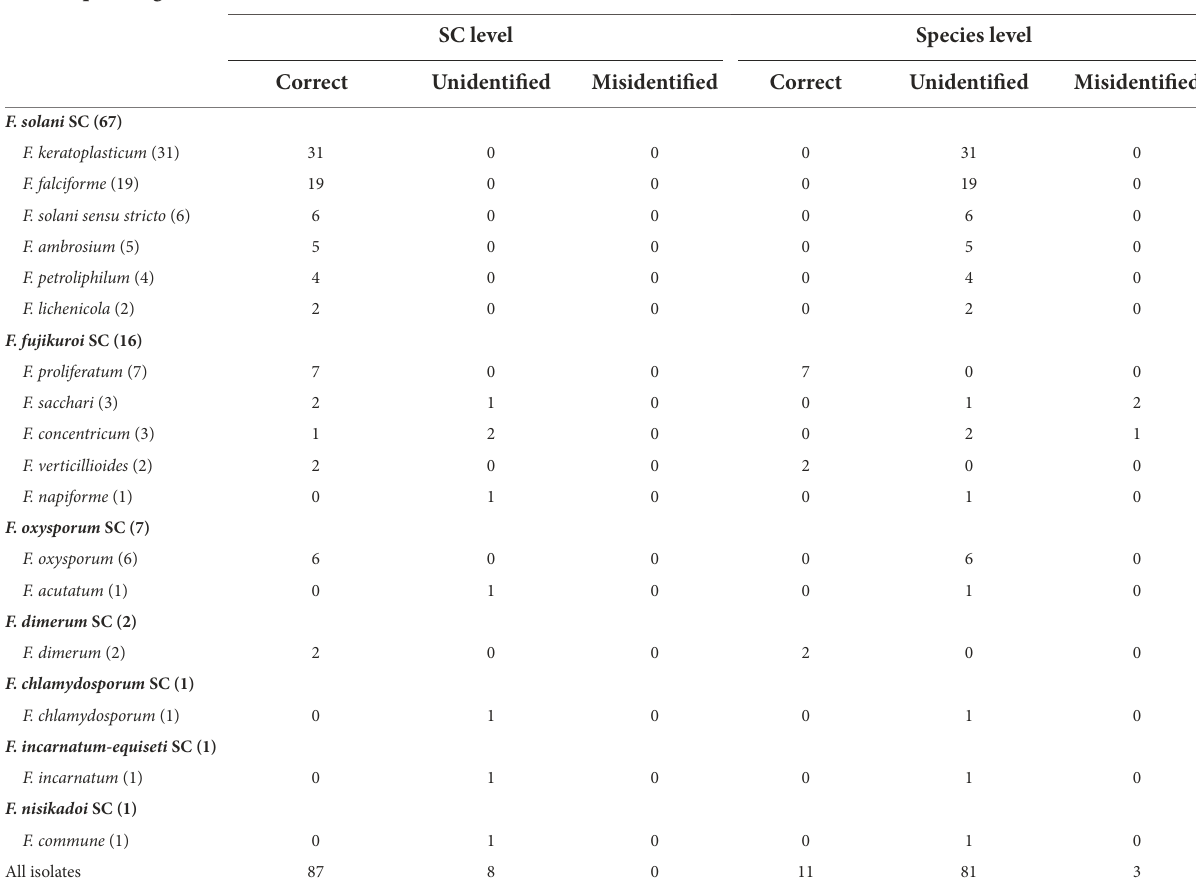
TABLE 1 Comparison of identification results of 95 clinical Fusarium strains using DNA sequencing of TEF1 α and MALDI-ToF MS methods. DNA sequencing